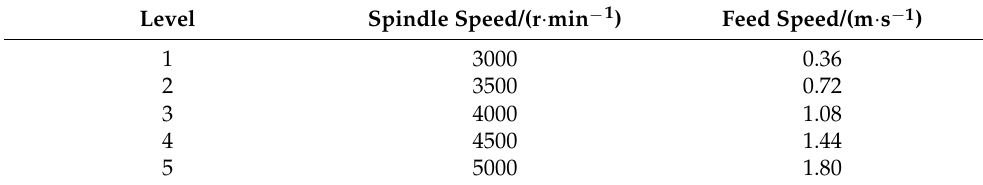
Table 1. Encoded experimental factors and